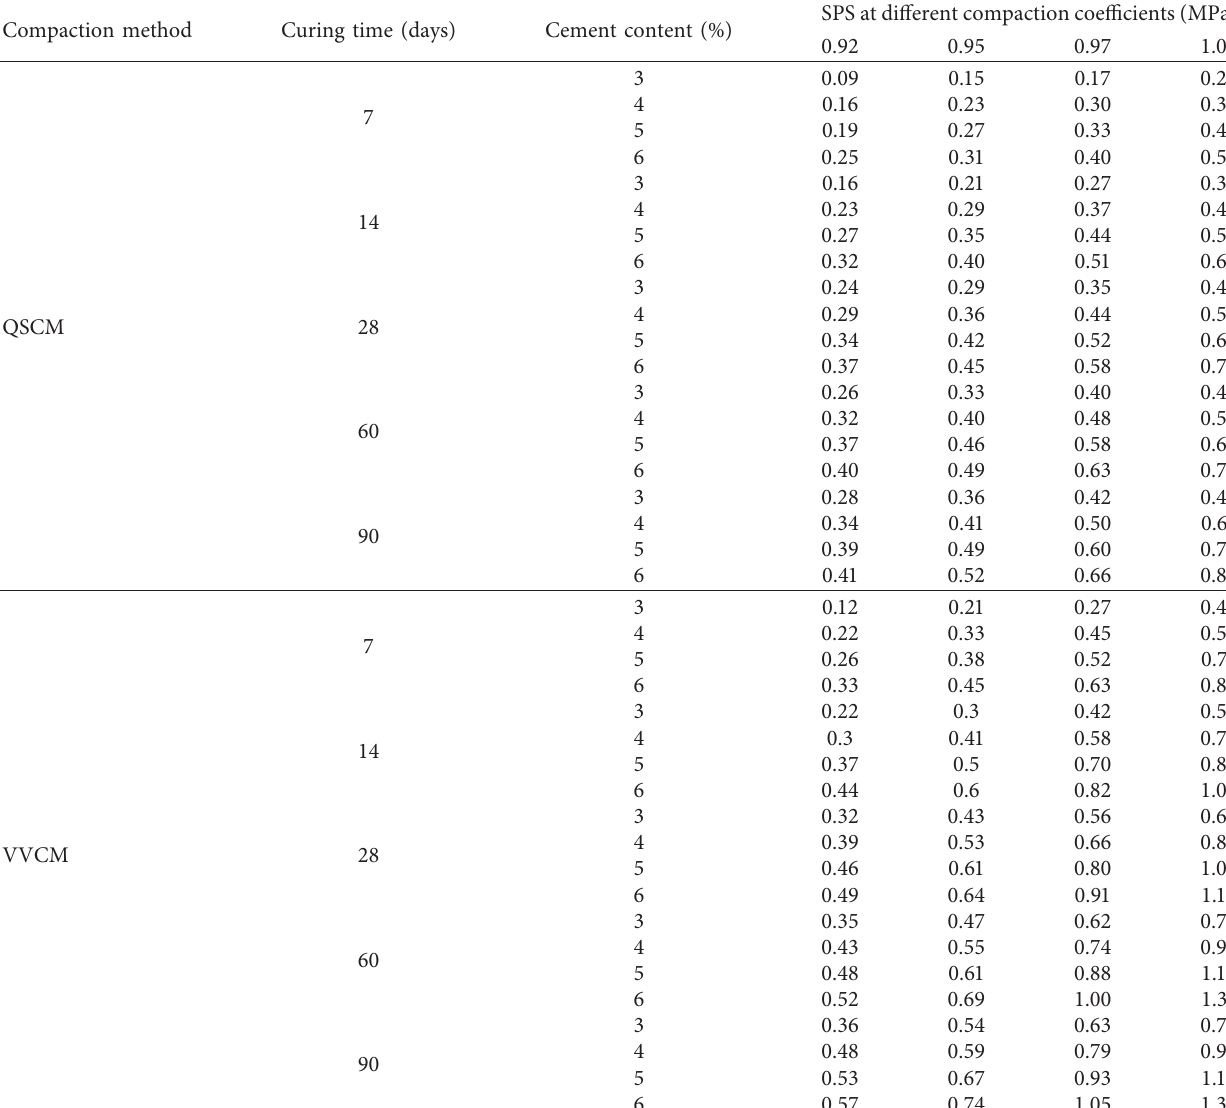
Table 8: SPS of CSL compacted using VVCM and